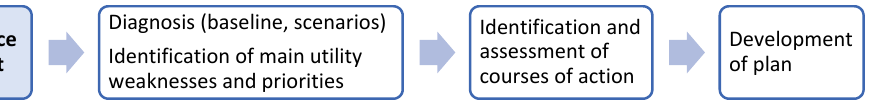
Figure 1. Typical planning in IAM.